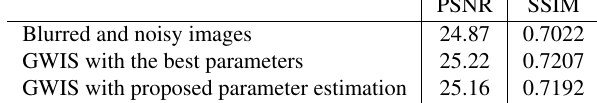
Table 1. Objective results for the testing